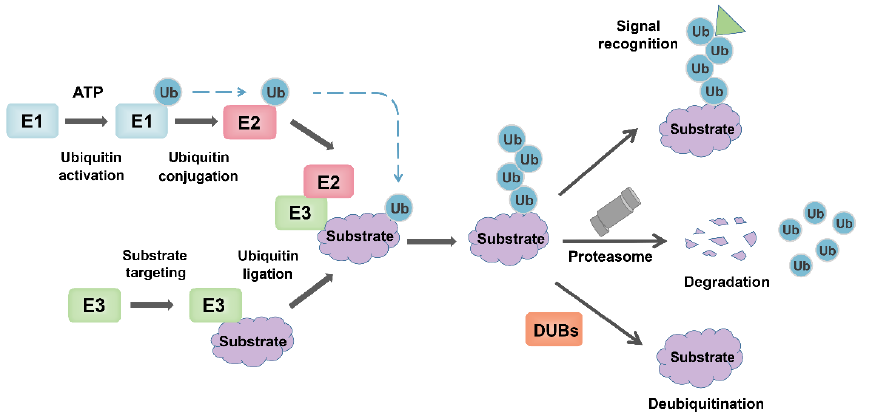
Figure 2. The overview of the ubiquitin-proteasome system. Ubiquitin is activated and bound to E1 in an ATP-dependent manner. Then, the activated ubiquitin is transferred to the E2, while the substrate protein to be degraded is specifically targeted by E3 ubiquitin ligase, and ubiquitin is ligated to the substrate. Ubiquitinated substrate proteins are recognized by the 26S proteasome and degraded into small peptides and amino acids. In contrast, DUB reverses ubiquitination by removing the polyubiquitin chains of proteins and maintains intracellular ubiquitin levels. In addition, some ubiquitination modifications that do not lead to degradation induce related biological effects through signal recognition, such as kinase activation, localization changes.